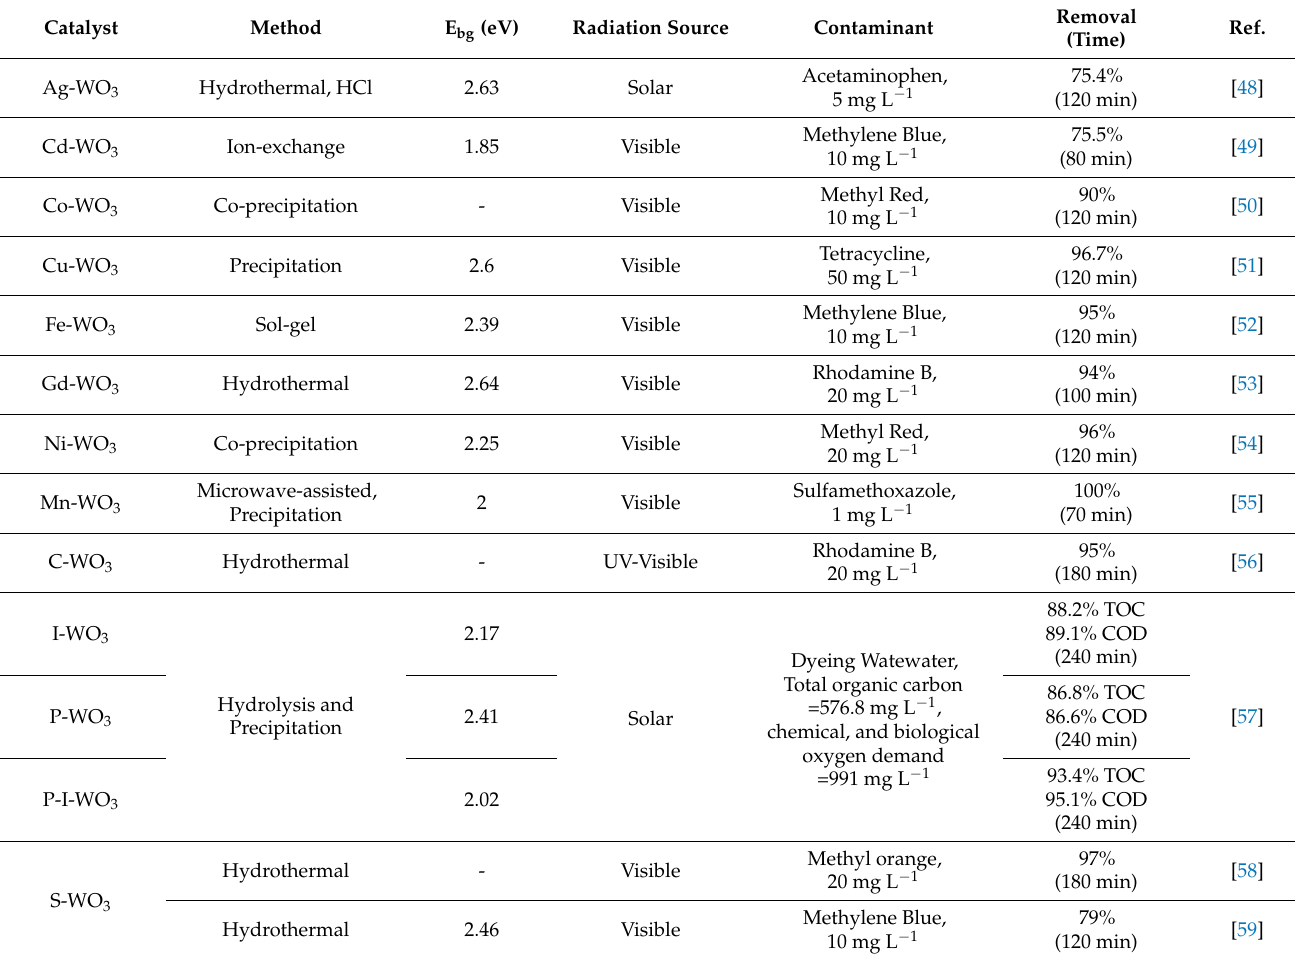
Table 1. Application of doped WO 3 for photocatalytic removal of